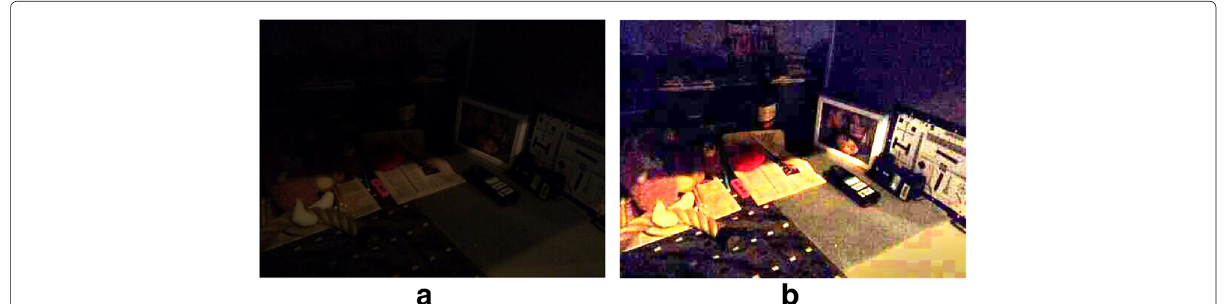
Fig. 8 Result of recovered scene radiance. a Original image. b Final recovered scene